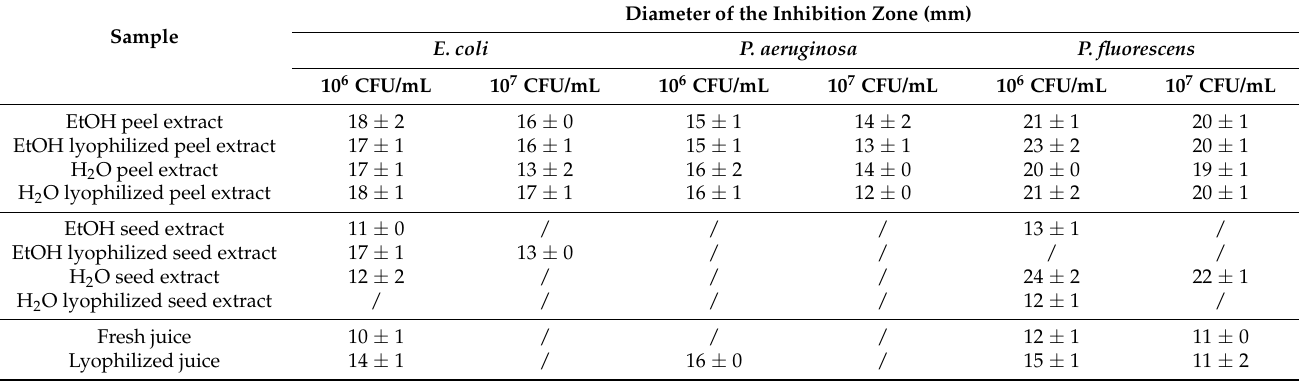
Table 3. Antibacterial activity of P. granatum samples on Gram-negative bacteria.